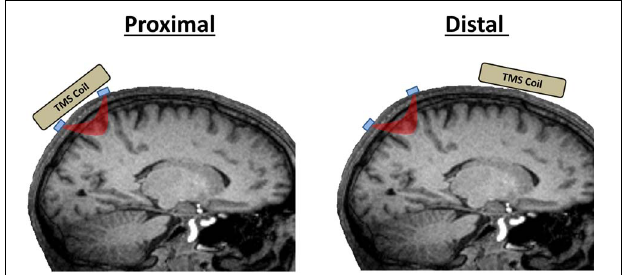
FIGURE 1 | Proximal vs. distal ROIs in TMS-fNIRS and TMS-EROS experiments. Proximal ROIs are those directly activated by a TMS coil. Distal ROIs are those activated trans-synaptically by TMS. Optodes are depicted in blue and the path of near-infrared light between an emitter and detector is depicted in